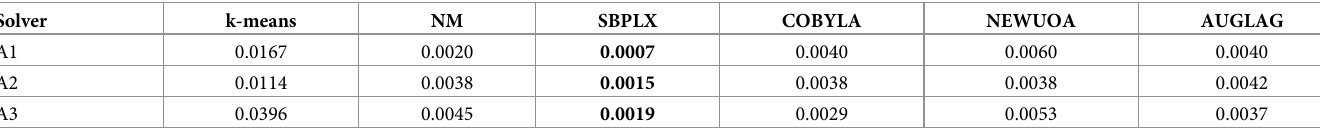
Table 2. Comparison of the optimized objective values regarding the optimization algorithms on the A-sets. The boldface indicates the best objective values in each subset. Solver